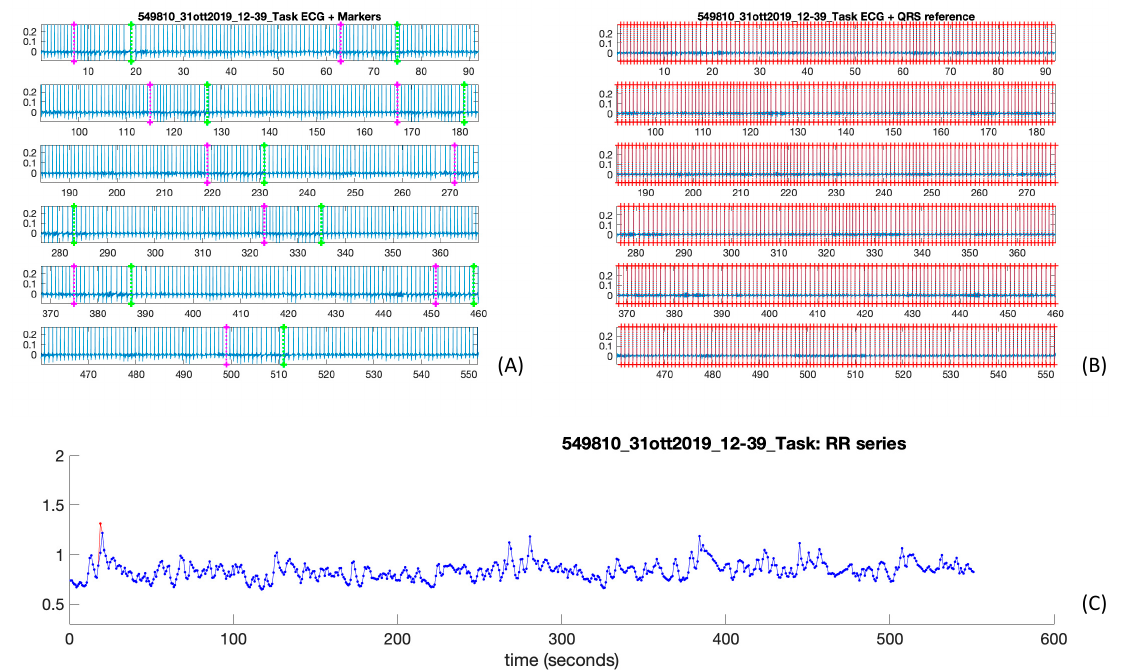
Figure 2. ECG signal processing for a sample data: ( A ) original ECG signal with the markers indicating the start (purple) and the end (green) of each odor stimulation;( B ) the same signal after the application of the QRS complexes detector (QRS markers indicated in red); ( C ) the RR series obtained from the ECG signal before (red) and after (blue)